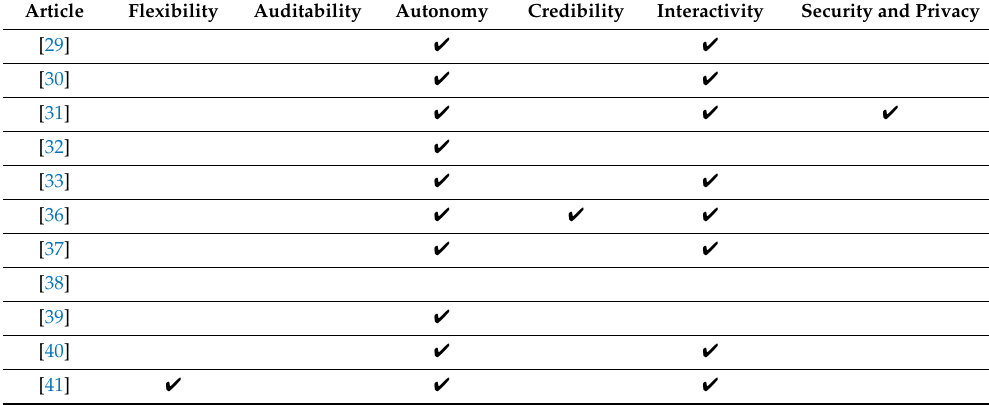
Table 8. Wellbeing